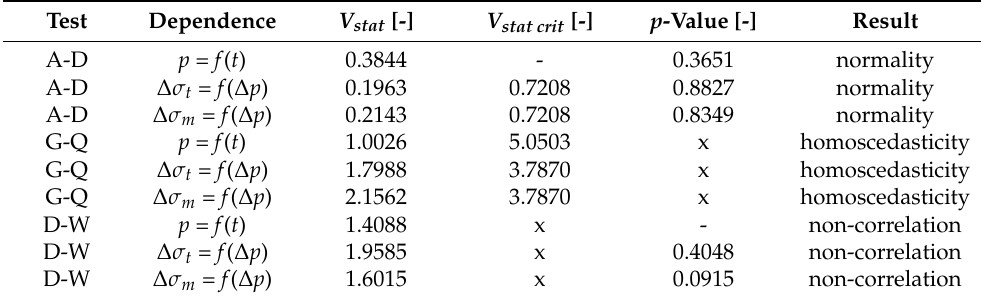
Table 5. Parameters of correlation analyses of applied polynomial models of individual regression dependencies p = f ( t ), ∆ σ t = f ( ∆ p ) and ∆ σ m = f ( ∆ p